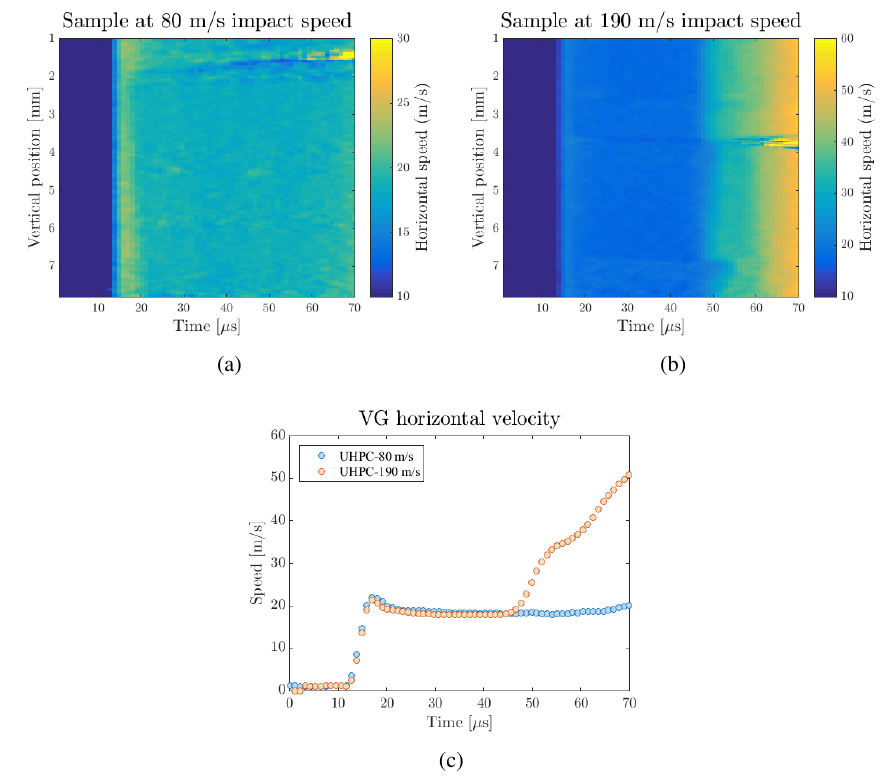
Figure 5: Space-time evolution of the rear face velocity profile for two tested